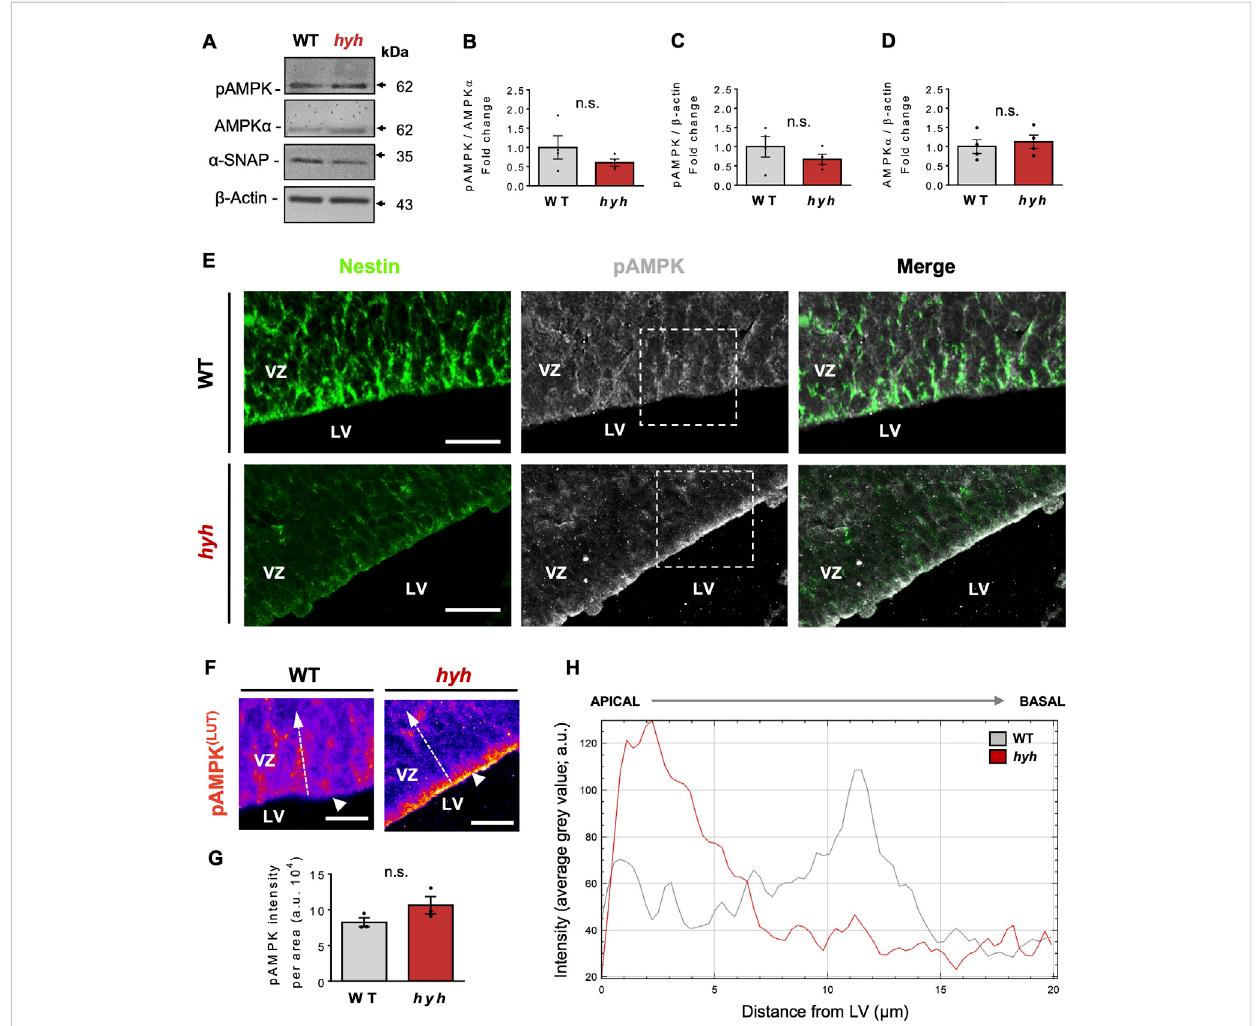
FIGURE 5 Expression and distribution pattern of phosphorylated AMPK in the telencephalon of hyh mice. (A) . Western blot analysis of proteins obtained from WTandhyhtelencephalonatE14.5usingantibodiesagainstpAMPK,totalAMPK α ,and α -SNAP. β -actinwasusedasloadingcontrol. (B – D) .Quanti fi cation of pAMPK protein levels normalized on total AMPK (B) and β -actin levels (C) , and total AMPK on β -actin protein levels (D) . The bars represent the mean ± SEM (n = 4). Differences with p < 0.05 were considered signi fi cant (Student ’ s t-test with Welch ’ s correction). n. s. = no signi fi cant differences. (E) . Dorsal ventricular zone (VZ) of brain coronal sections from WT (E) and hyh (F) mice at E14.5 immunostained for Nestin (green) and pAMPK (grey). Dashed rectangles depict the zoomed area displayed in F (WT and hyh , respectively). (F) . Pseudocolored LUT (Look Up Table) high magni fi cation images of the areas indicated by dashed rectangles in E (pAMPK). Note the changes in pAMPK immunoreactive pattern in the most apical region of the VZ in hyh mice (whitearrowheads). (G) .Quanti fi cationofpAMPKimmuno fl uorescenceintensityintheVZ.Oneregion ofinterest(ROI) of2,000 μ m 2 (20 µmlengthfrom ventricular surface, 100 µm width) was considered in each section (4 sections per animal, three animals per condition). The bars represent the mean ± SEM (n = 3). Differences with p < 0.05 were considered signi fi cant (Student ’ s t-test with Welch ’ s correction). n. s. = no signi fi cant differences. (H) . Plot of pAMPKimmuno fl uorescenceintensitypro fi leintheapicalVZ(asdepictedwithdashedwhitearrowsinFforWTandhyh,respectively.Adistanceof20 µm perpendicular to the ventricular surface (apical to basal) was measured. Note the increased immuno fl uorescence intensity of pAMPK in the most apical region of the VZ in hyh mice. LV, Lateral ventricle. Scale Bars: E = 20 µm, F = 10